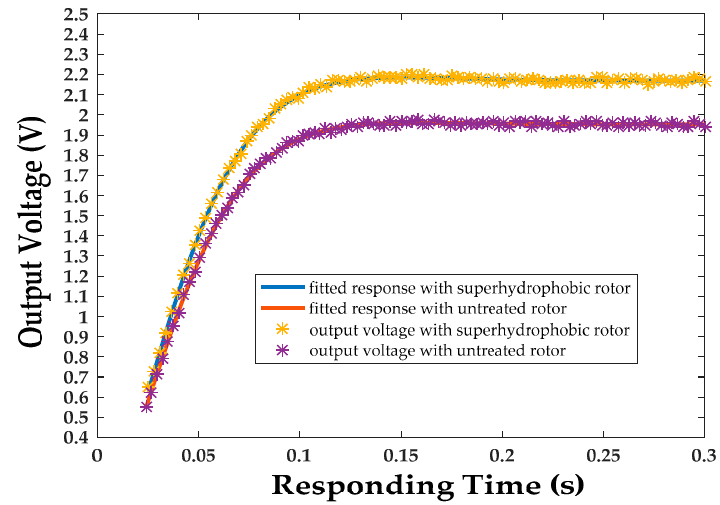
Figure 7. Fitted curve of the output voltage under the step angular speed input of 20°/s for gyroscopes with and without a superhydrophobic rotor.